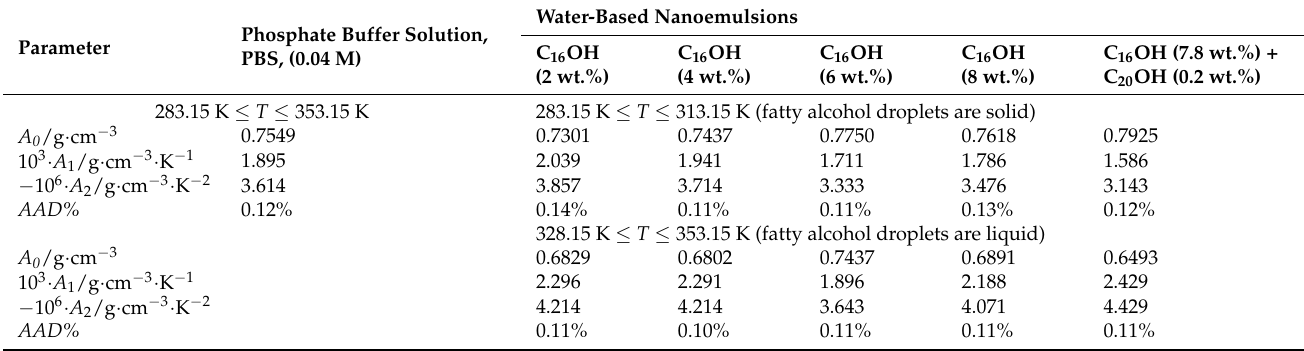
Table 4. The A i coefficients and percentage absolute average deviations, AAD% , obtained from second-order polynomial fittings of the density